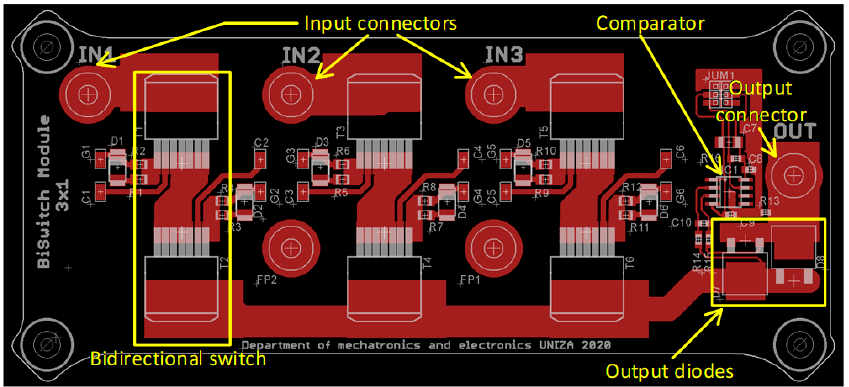
Figure 4. Design of the power IMS board.